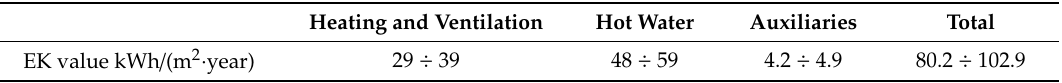
Table 2. The range of EK values for typical multi-family buildings designed according to current standards equipped with a heat substation supplied from the municipal heating